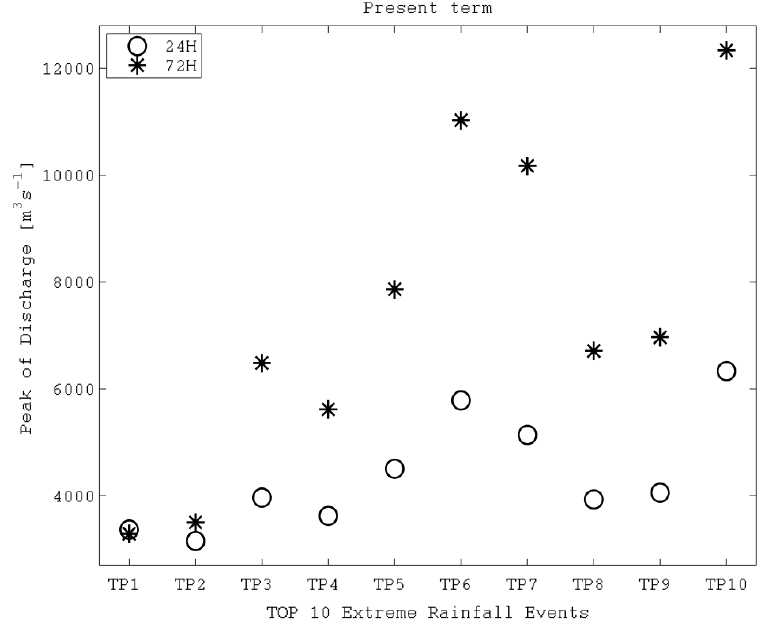
Figure 7. Present-term peaks of discharge from TP 1 to TP 10 without the modified ranking method coefficients for each period (24 and 72 h) at the dam inlet.